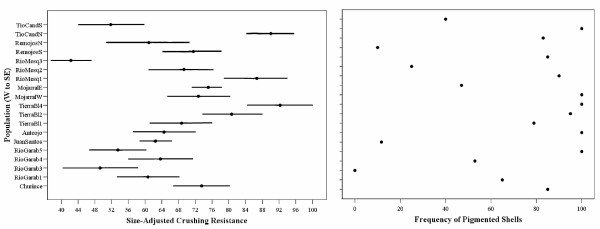
A) Average size-adjusted crushing resistance (95% Confidence Intervals) for M. churinceanus populations. B) Frequency of banded snails for M. churinceanus populations. Populations along the Y-axis are arranged on a transect from southwestern populations to the northern Rio Mesquite down to the southeastern lobe.